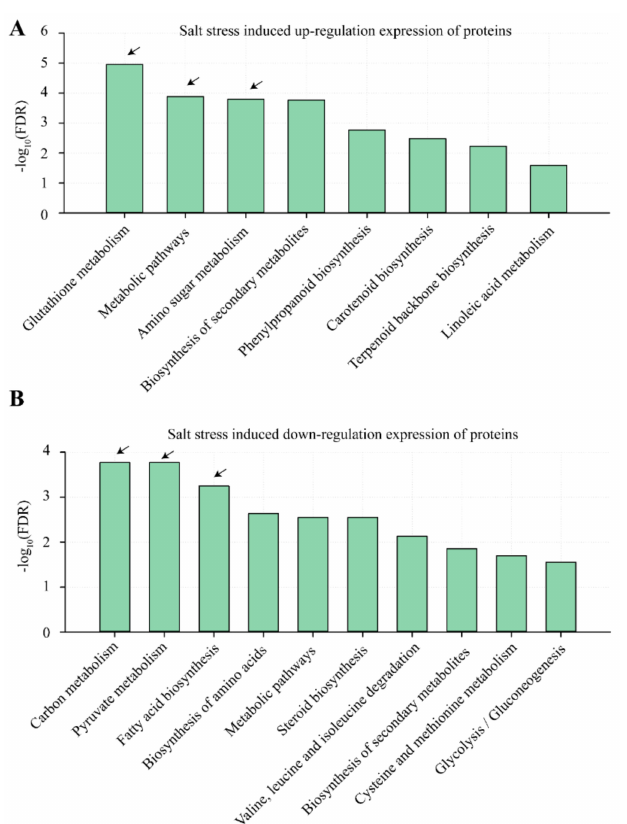
Figure 5. Gene ontology (GO) analysis on salt stress induced up- / down-regulation of expressed proteins. Panels ( A , B ) represent up- / down-regulation of proteins induced by 200 mM NaCl treatments in alfalfa seedlings during 14 d. The arrow represents the key biological pathways highlighted in this study. FDR means false discovery